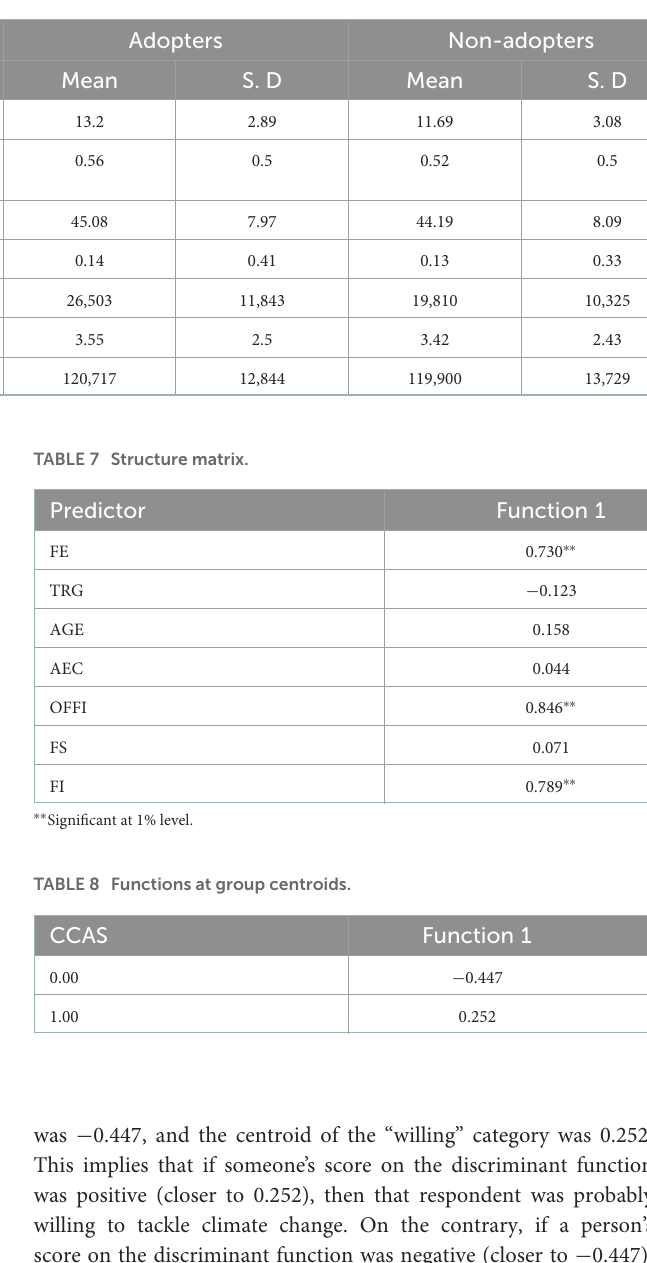
TABLE 4 Descriptive statistics (Group means) across selected categories of farmers.